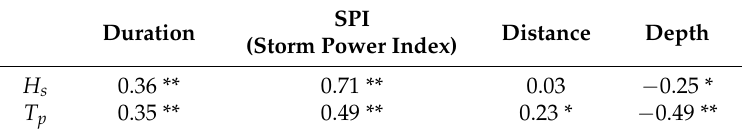
Table 2. Spearman rank correlation coefficient between the wave height and period at the peak of each storm, versus the storm duration and the total energy released by the storm, and the distance and depth of forcing cyclones (*/** statistically significant at 95%/99% confidence level).